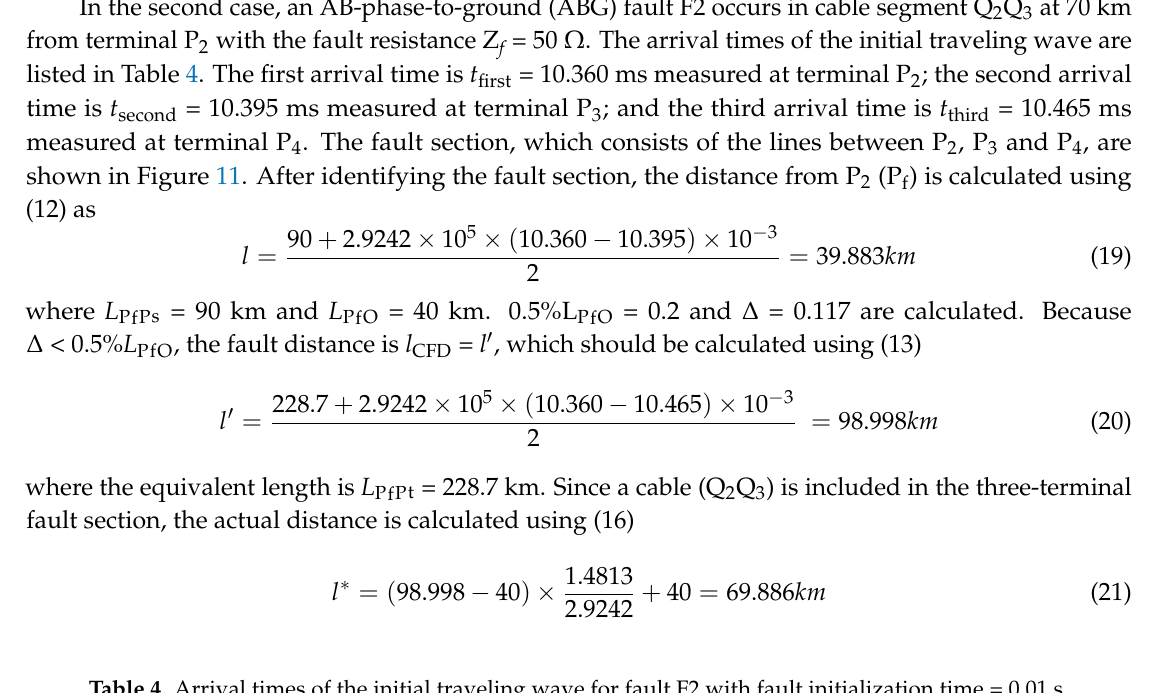
Figure 10. Identified three-terminal fault section for fault F1.